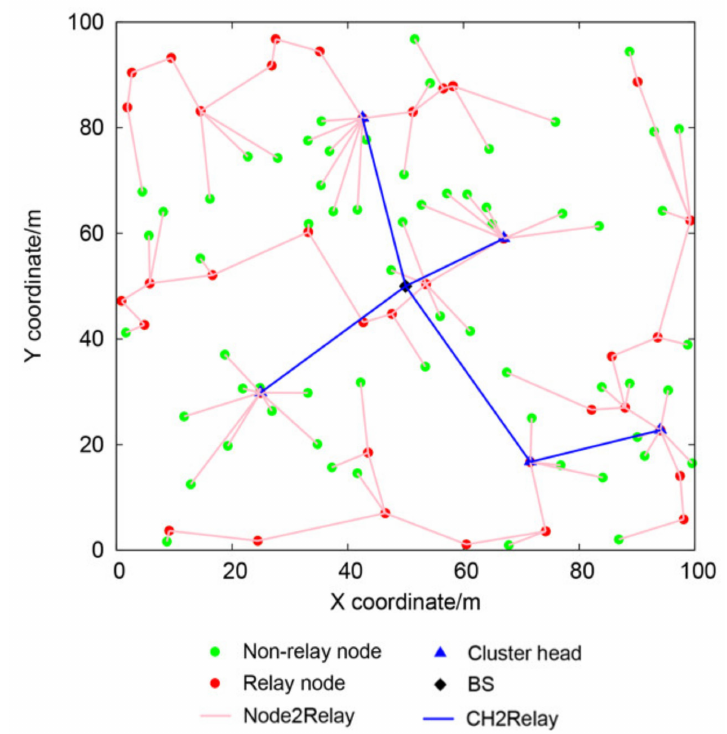
Figure 5. The topology of the